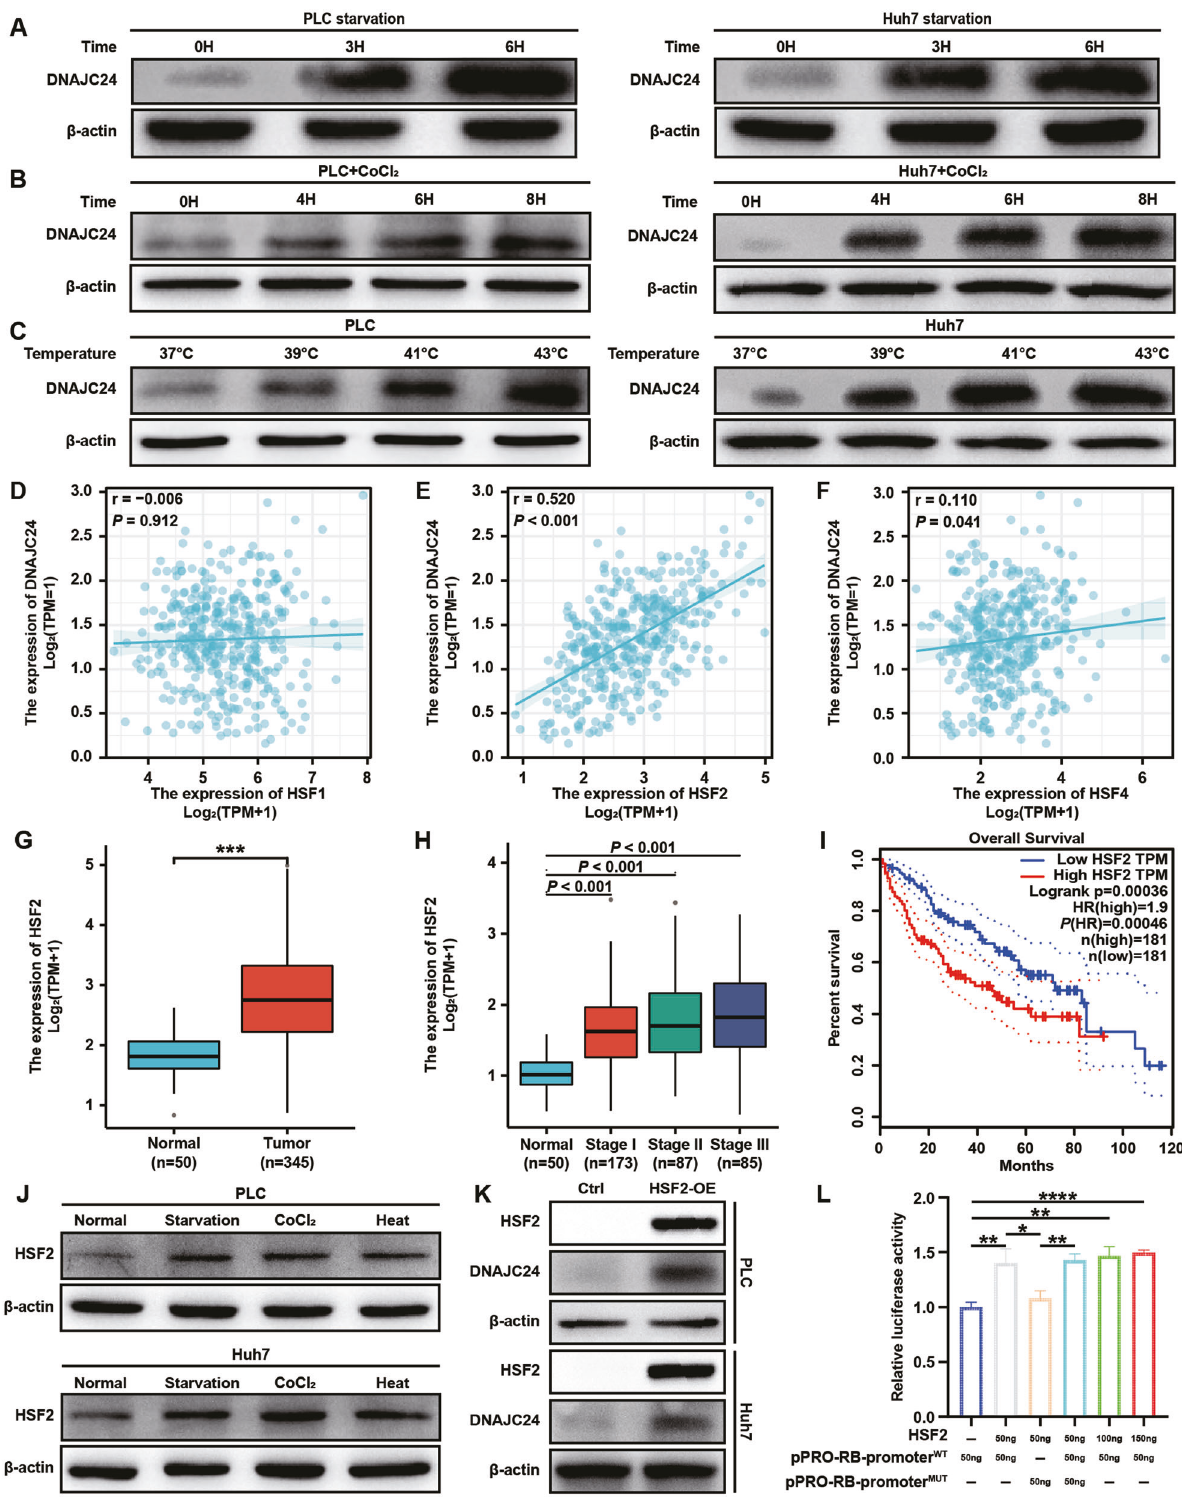
lentivirus, which allows us to discriminate between early autophagosomes from acidi fi ed autophagolysosomes [37]. Con- sistent with the results obtained from Western blotting, we observed an increased number of mRFP-positive puncta and larger LC3 dots in DNAJC24-KD cells, suggesting more LC3 accumulation in DNAJC24-KD cells. Strikingly, by quantifying the